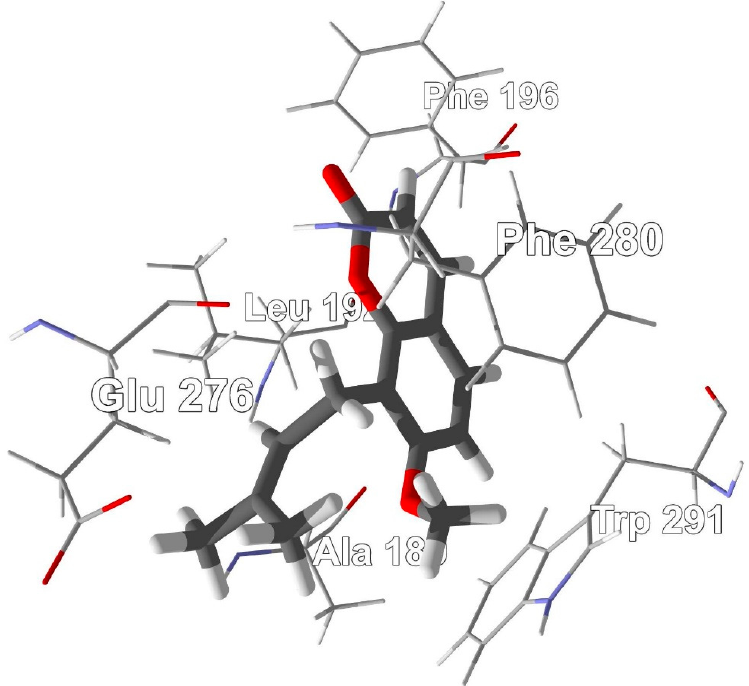
Figure 5. The allosteric binding site of human protein tyrosine phosphatase 1B (PTP-1B, PDB 1T48) with the lowest-energy docked pose of osthole.